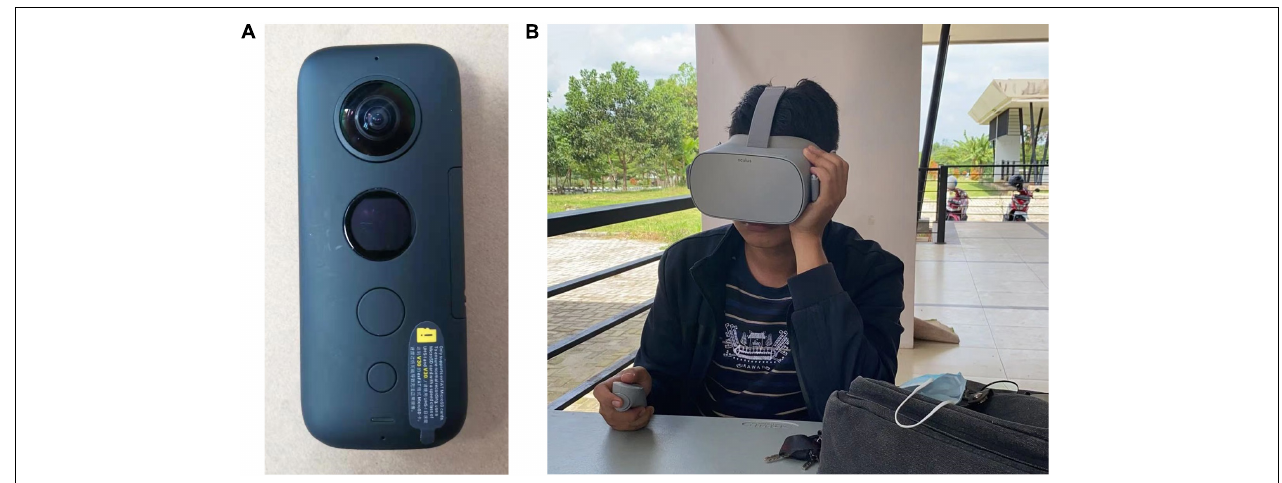
FIGURE 1 | (A) Insta 360 one (https://www.insta360.com/) and (B) MI VR glasses (https://xiaomi-mi.com/). Image source: Author’s own